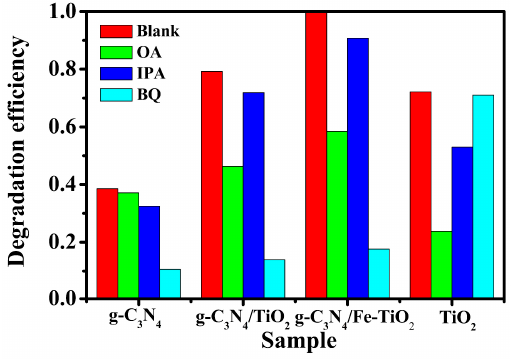
Figure 8. Trapping of reactive specie experiments for g ‐ C 3 N 4 , CT, 0.05Fe ‐ CT, and TiO 2 .